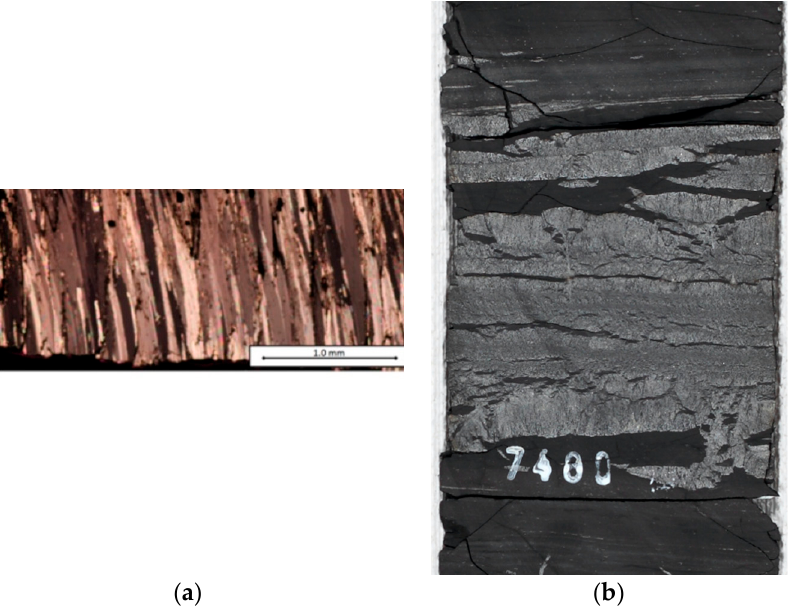
Figure 8. Thin section image ( a ) and core slab image ( b ) from well 13-10A showing fibrous calcite- filled fracture or “beef”. Core slab is approximately 10 cm in